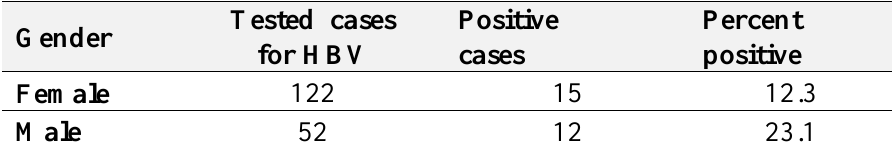
Table 1. Testing results by gender